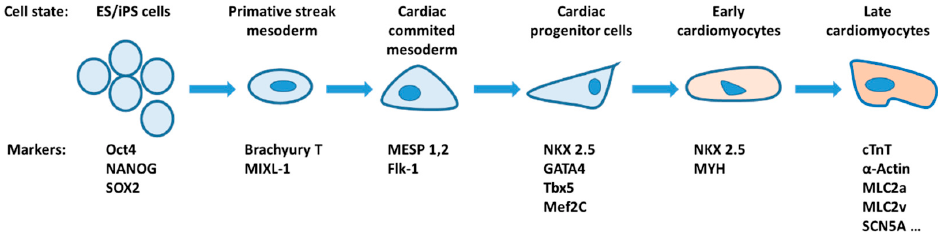
Figure 3. Cardiac differentiation. The scheme represents the different cell states during cardiac differentiation from pluripotent stem cells with the corresponding molecular markers. Adapted from [120].